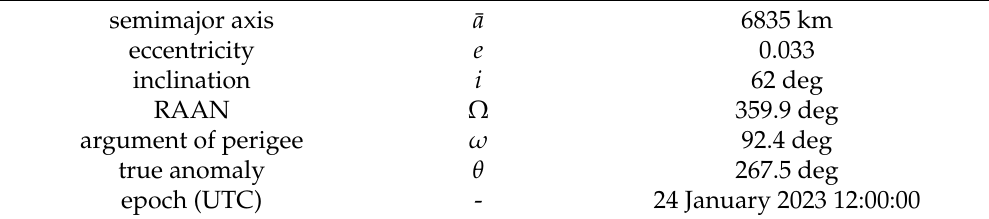
Table 14. Guidance strategy: orbit parameters of reconnaissance satellite.